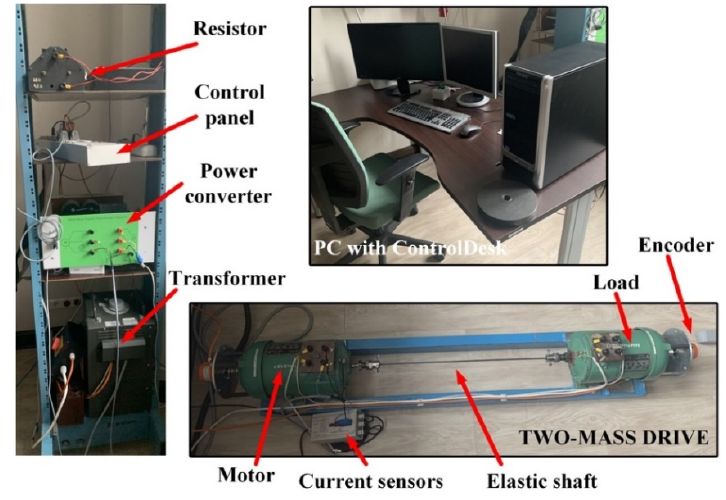
Figure 17. The laboratory setup.